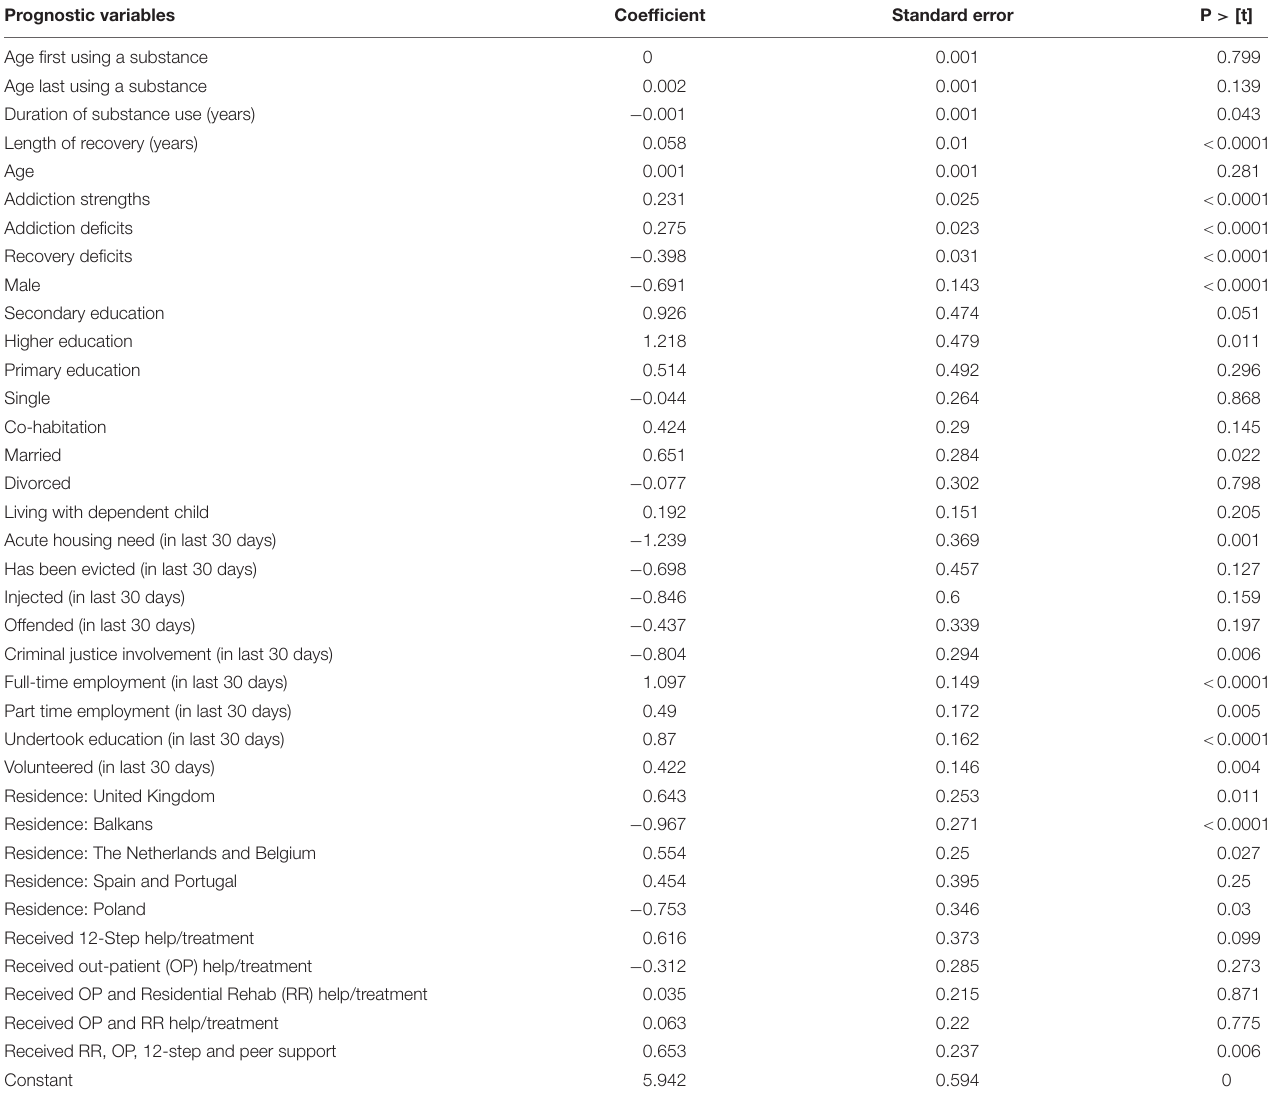
TABLE 6 | Linear regression model of growth in recovery